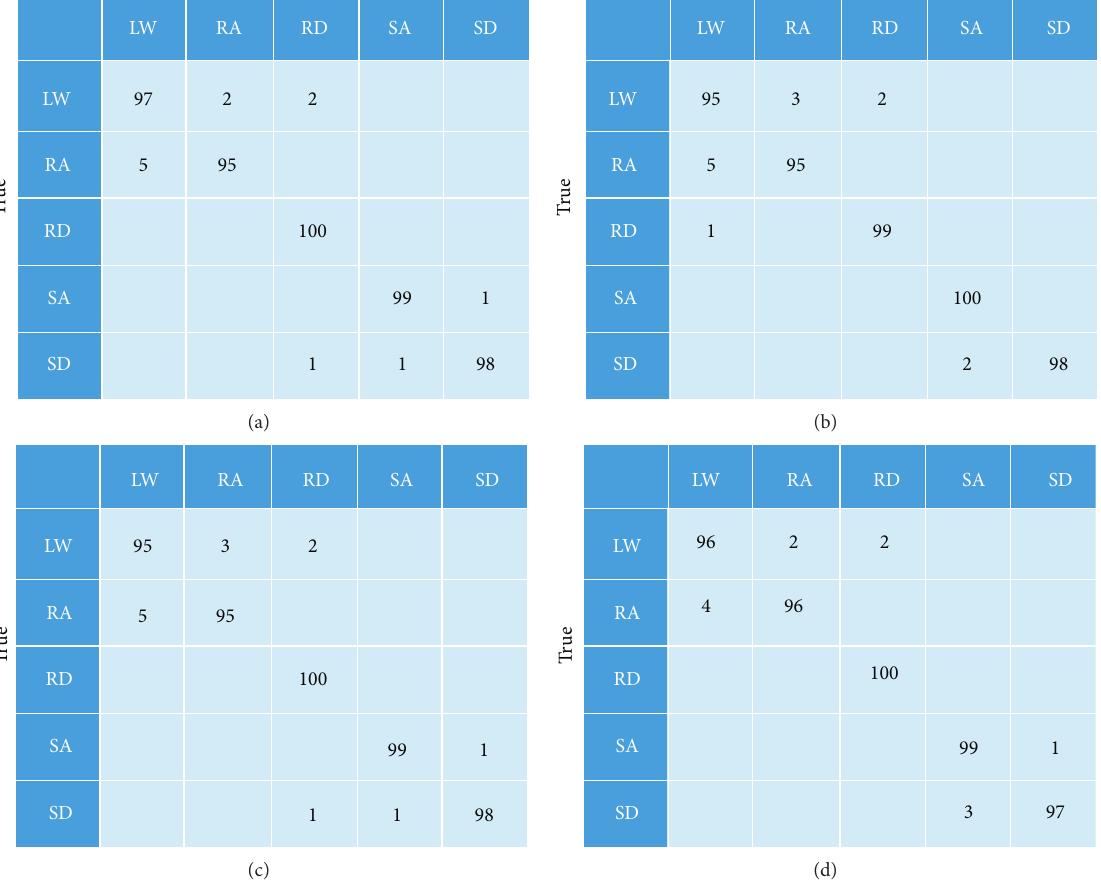
Figure 6: Confusion matrix for steady-state recognition from different classifiers. (a) LDA+ SVM confusion matrix estimation. (b)